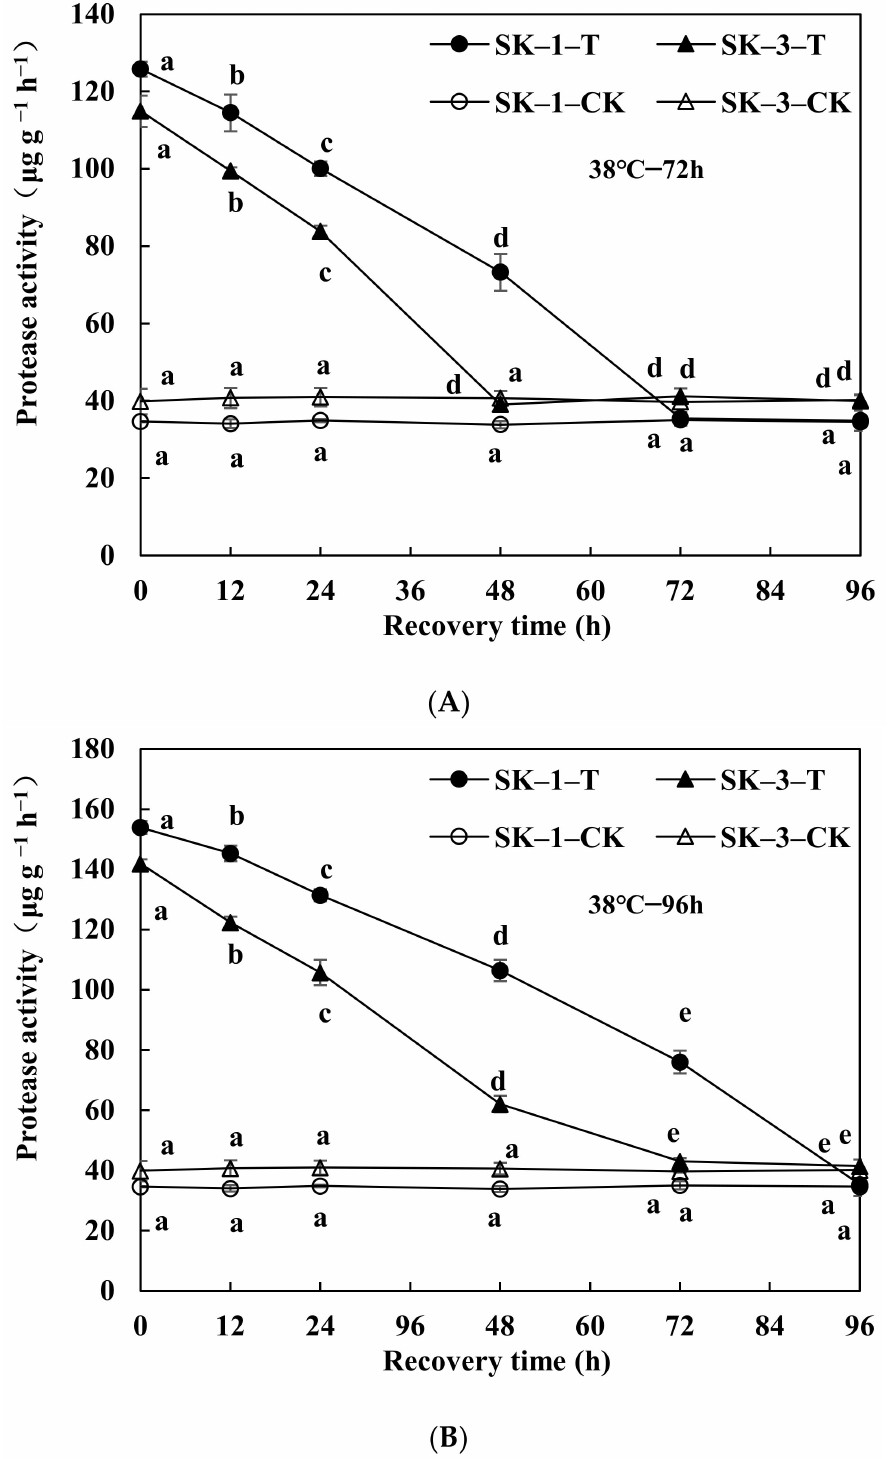
Figure 6. Changes in protease activities in squares of Bt cotton after 72 h ( A ) and 96 h ( B ) high- temperature stress termination. Protease activity at the recovery time with different lowercase letters is significantly different from the control at p < 0.05 under the same high-temperature stress duration for the same cultivar. T—treatments for 72 h ( A ) and 96 h ( B );